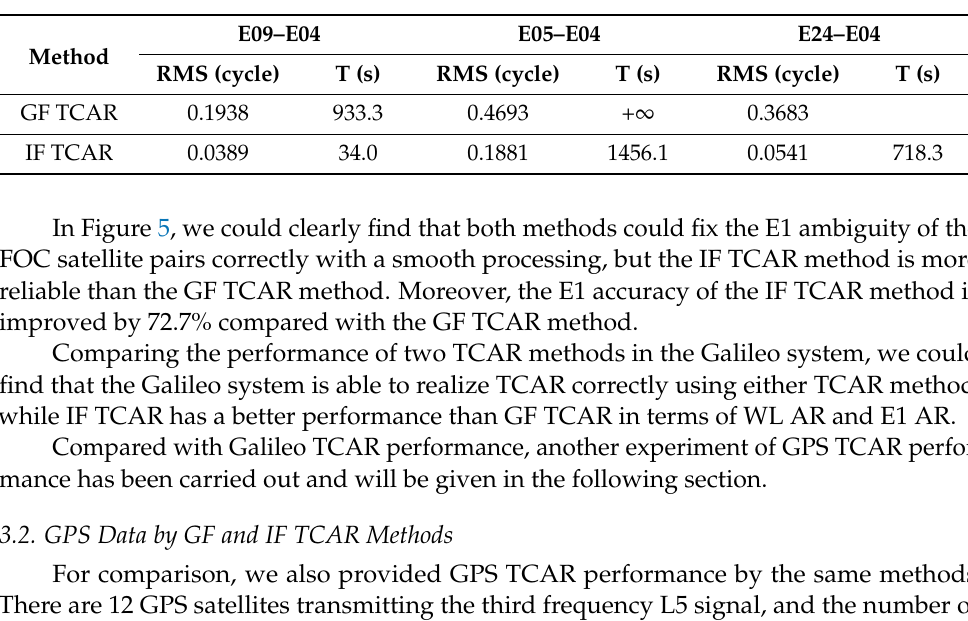
Figure 5. The optimal E1 ambiguity residual by GF TCAR method (upper row) and IF TCAR method (lower row), as well as the satellite elevation angle by two TCAR methods. ( a , d ) are the GF and IF of E09–E04; ( b , e ) are the GF and IF of E05–E04; ( c , f ) are the GF and IF of E24–E04. Table 3. The mean RMS of the E1 ambiguity residuals and the convergence time.